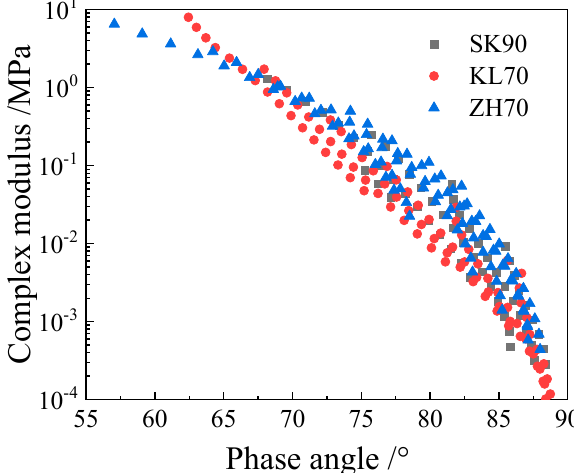
Figure 3. Black diagrams of the four asphalt binders.